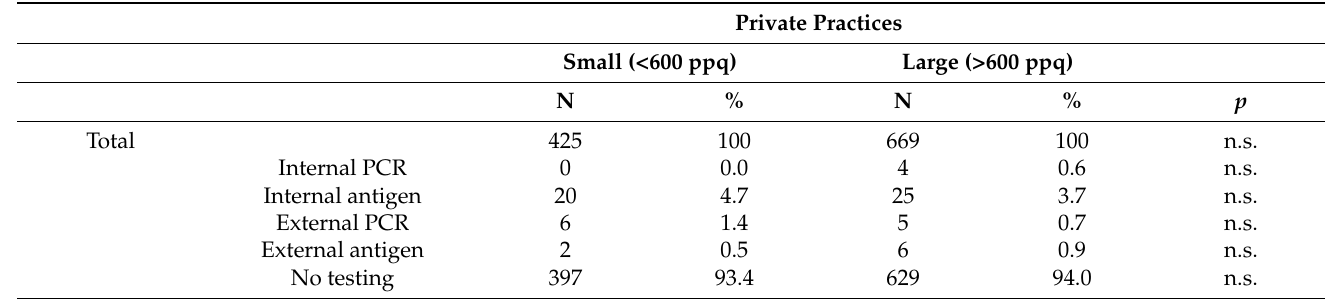
Table 4. Methods and distribution of pre-interventional testing of outpatients and